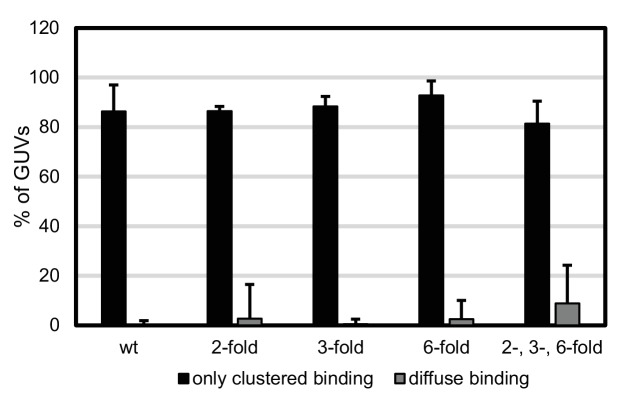
Type of Gag binding to GUVs in the presence of RNA.Statistics of Gag membrane binding was performed as for Figure 3g, using the data presented in Figure 4f–j (ten z-stacks per condition, in three independent repeats).